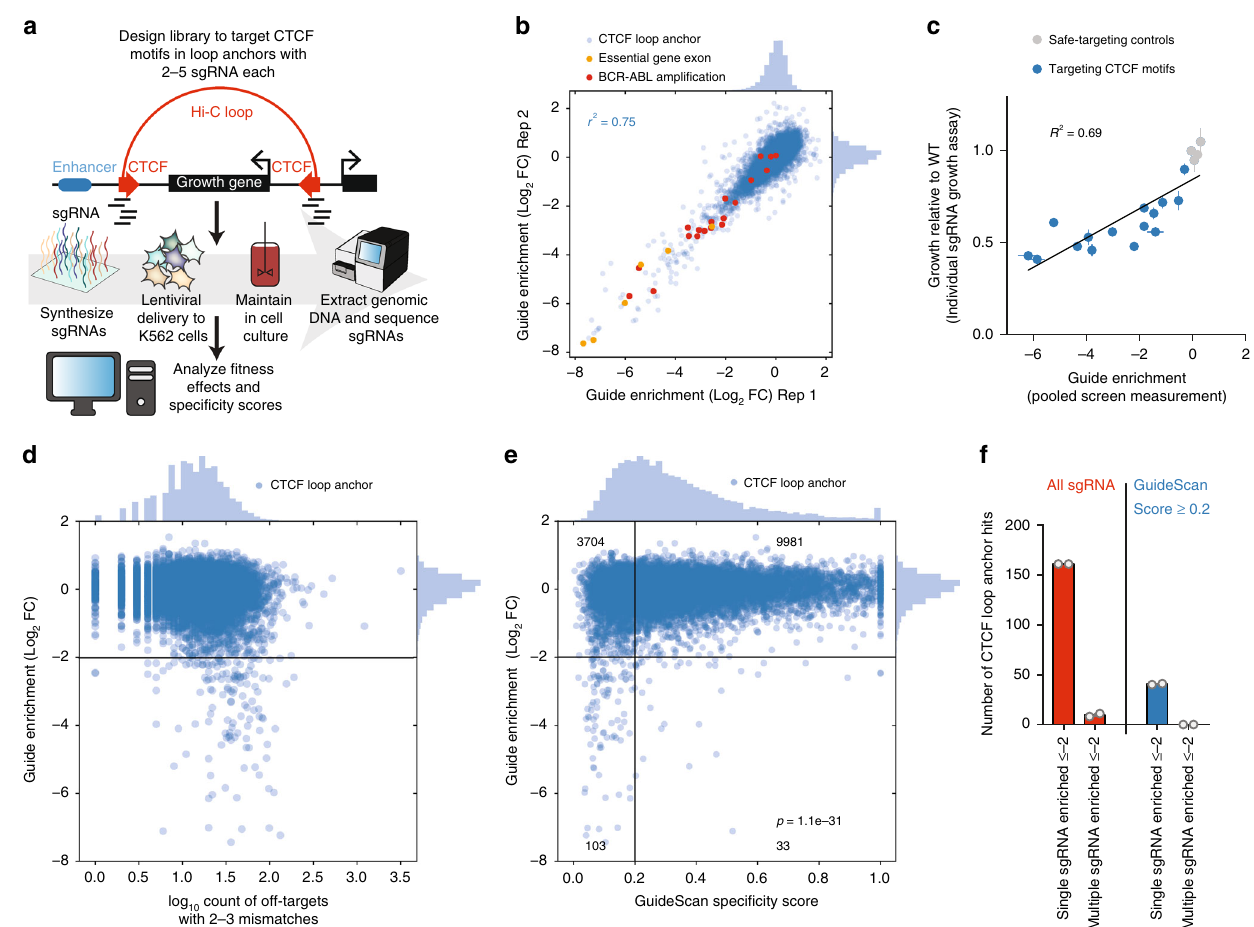
Fig. 1 GuideScan speci fi city fi ltering of a genome-scale CRISPR-Cas9 screen for essential CTCF loop anchors. a Schematic of CTCF loop anchor motif screen, with 2 to 5 sgRNAs targeting each CTCF motif. b Fitness effects are reproducible between independently transduced biological replicates of the screen. sgRNAs targeting essential gene exons or the BCR-ABL ampli fi cation drop out during the growth screen, as expected. Guide enrichment values are the log 2 (fold-change) of an sgRNA ’ s sequencing counts from after the screen compared with the original plasmid pool, computed with the casTLE screen analysis software 5 . c The growth effects of CTCF motif-targeting sgRNA are validated in individual competitive growth assays after lentiviral delivery of single guides to K562-Cas9 cells. Error bars are standard deviation of three technical replicates. d Comparison of sgRNA fi tness effects with the number of off-target sites with 2-3 mismatches. Any sgRNAs with off-target sites with only 0 or 1 mismatch, as determined by the GuideScan search algorithm,